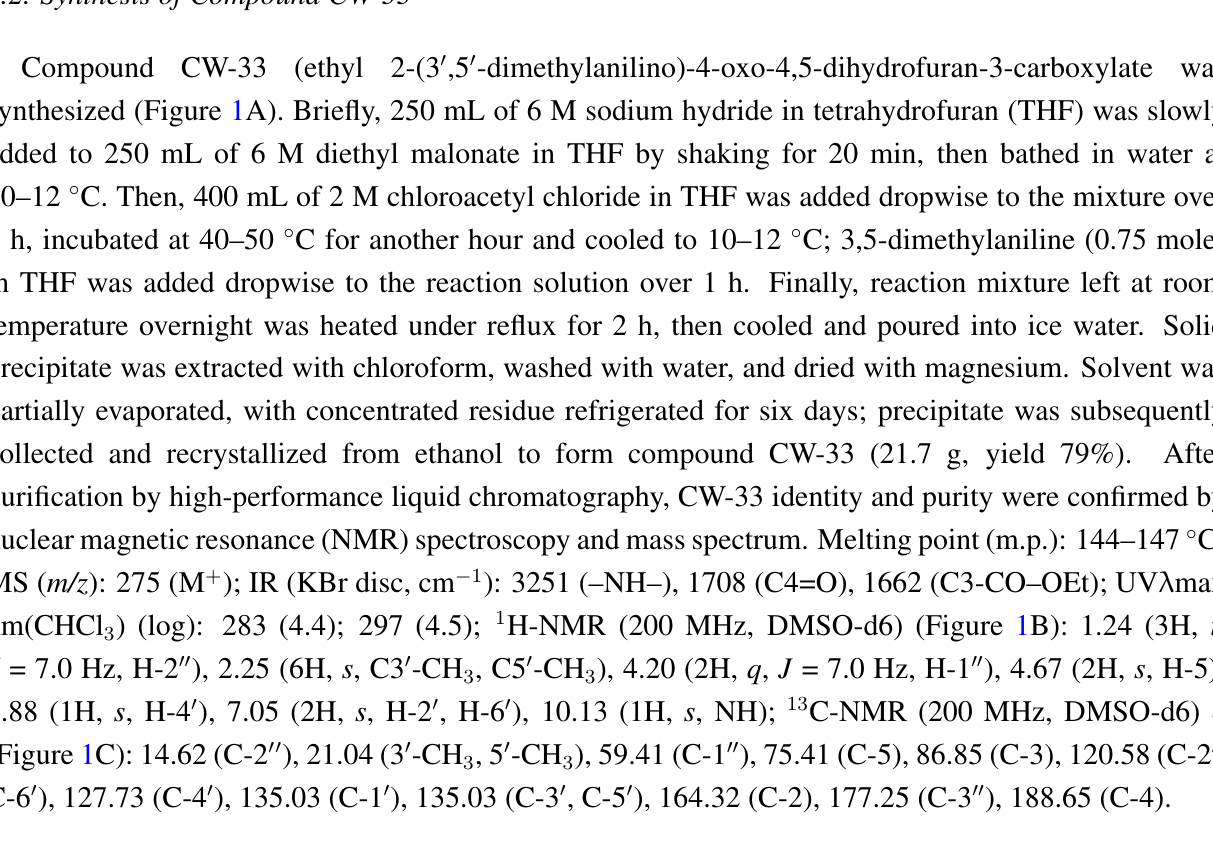
(Figure 1C): 14.62 (C-2 (cid:48)(cid:48) ), 21.04 (3 (cid:48) -CH C-6 (cid:48) ), 127.73 (C-4 (cid:48) ), 135.03 (C-1 (cid:48) ), 135.03 (C-3 (cid:48) , C-5 (cid:48) ), 164.32 (C-2), 177.25 (C-3 (cid:48)(cid:48) ), 188.65